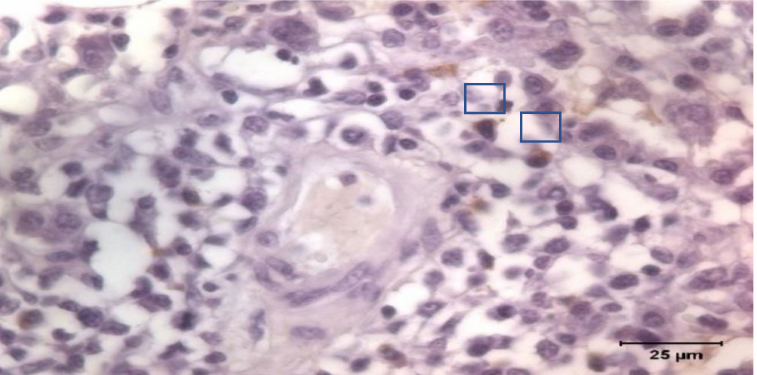
Figure 1. Immunostaining of IgA producing cells in lung. Detail of stained